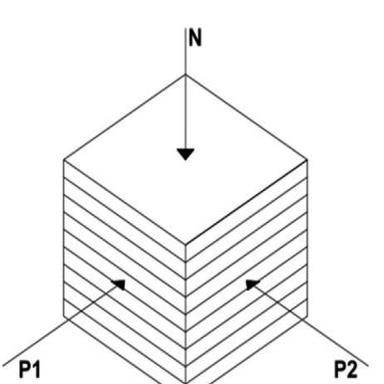
Schematic representation of specimens' planar structure directions according to NP EN 1926:2000.